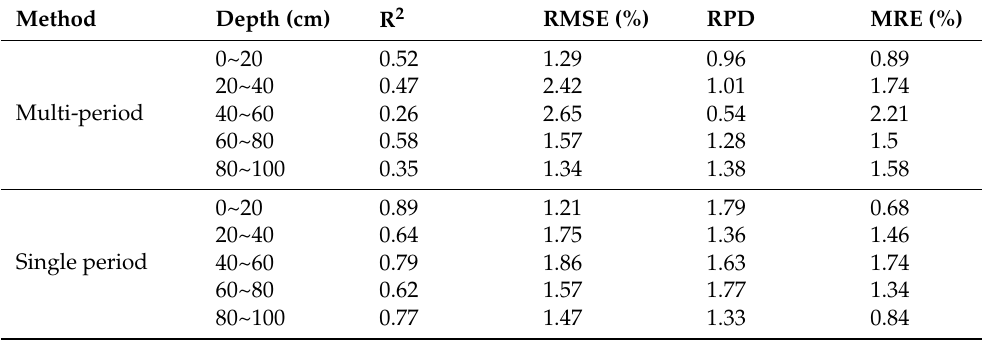
Table 6. Accuracy assessment of single period model and multi-period model. Note: R 2 , coefficient of determination; RMSE, root mean square error; RPD, Relative percent deviation; MRE, Mean relative error.